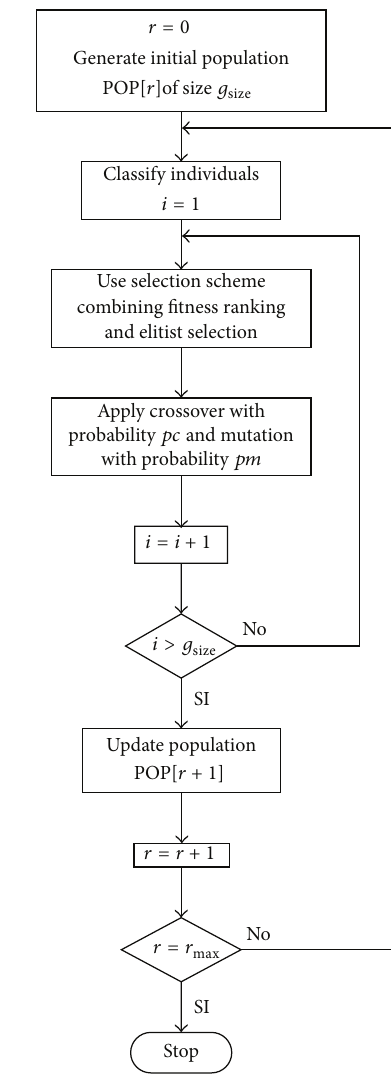
Figure 1: Flow chart for the evolutionary optimization